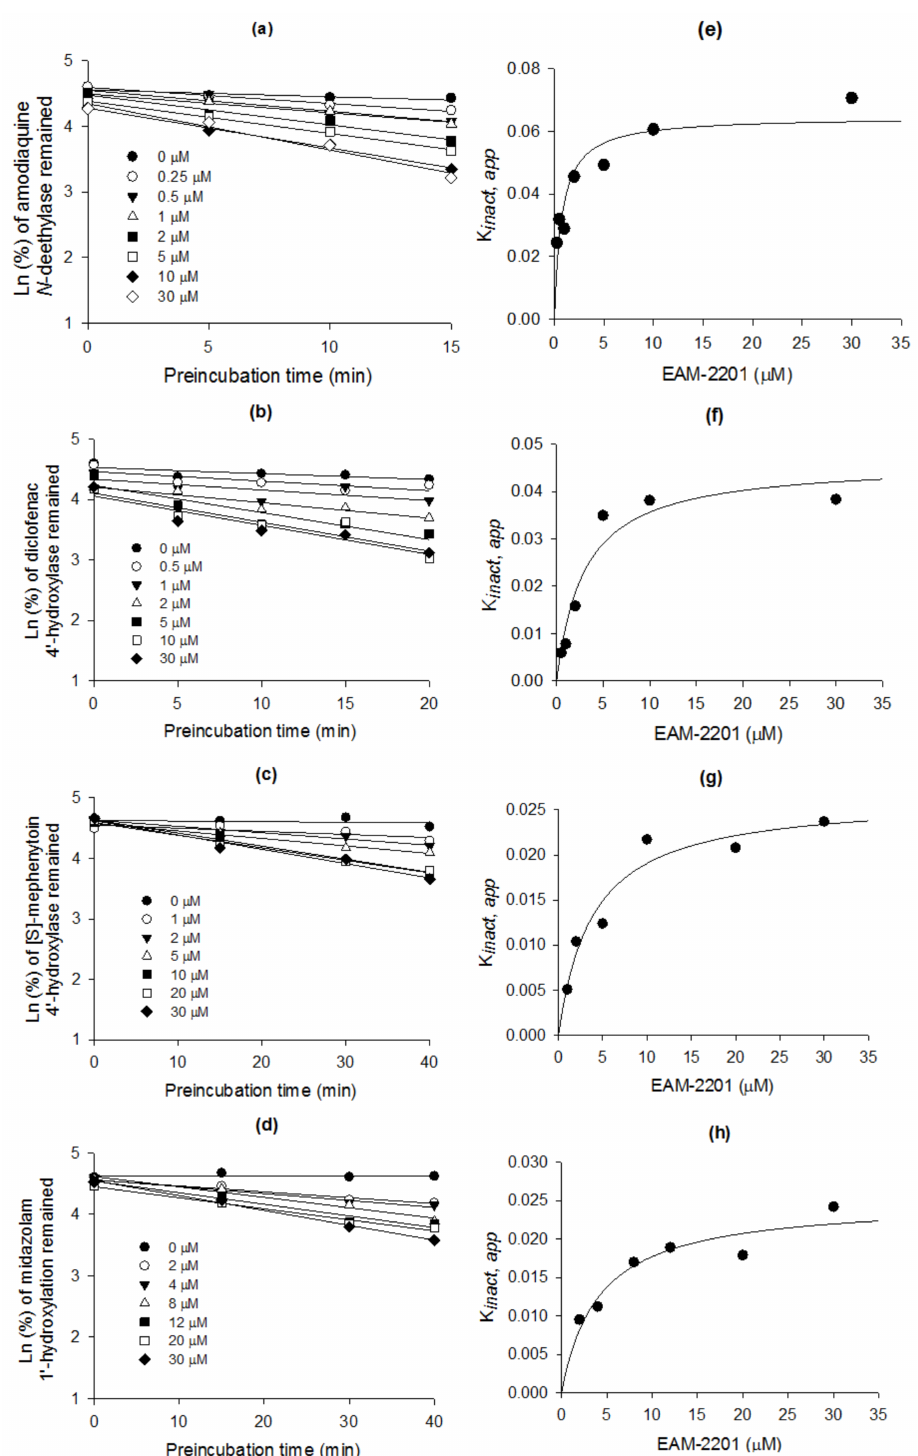
Figure 3. Inactivation kinetics of ( a ) N -desethylamodiaquine formation from amodiaquine; ( b ) 4 (cid:48) -hydroxydiclofenac formation from diclofenac; ( c ) 4 (cid:48) -hydroxy-[ S ]-mephenytoin from [ S ]-mephen ytoin; and ( d ) 1 (cid:48) -hydroxymidazolam from midazolam in human microsomes by various concentrations of EAM-2201. Relationship between k obs and EAM-2201 concentrations to estimate k inact and K i values for ( e ) CYP2C8-mediated amodiaquine N -deethylation; ( f ) CYP2C9-mediated diclofenac 4 (cid:48) -hydroxylation; ( g ) CYP2C19-mediated [ S ]-mephenytoin 4 (cid:48) -hydroxylation; and ( h ) CYP3A4-mediated midazolam 1 (cid:48)